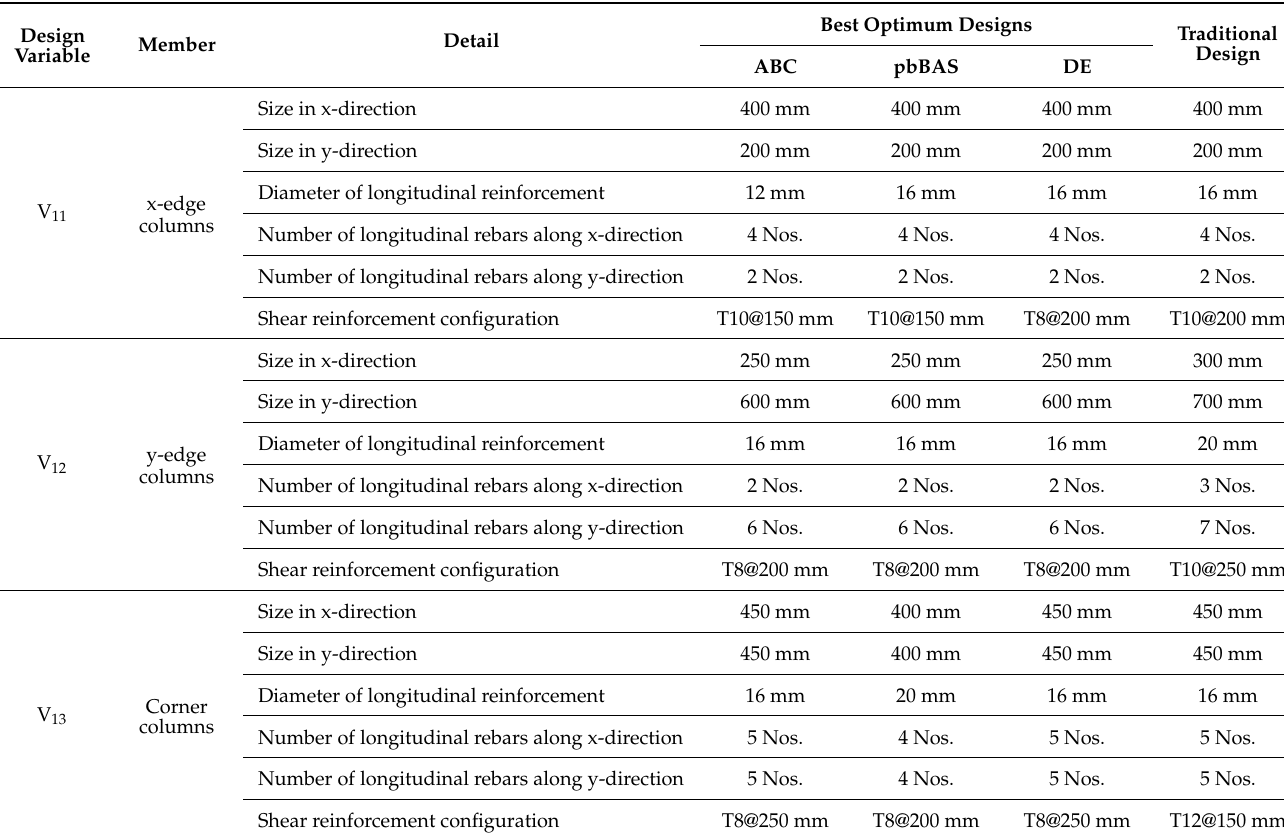
Table 17. Optimum values of column’s variables obtained by each metaheuristic algorithm for the V-type folded plate roof